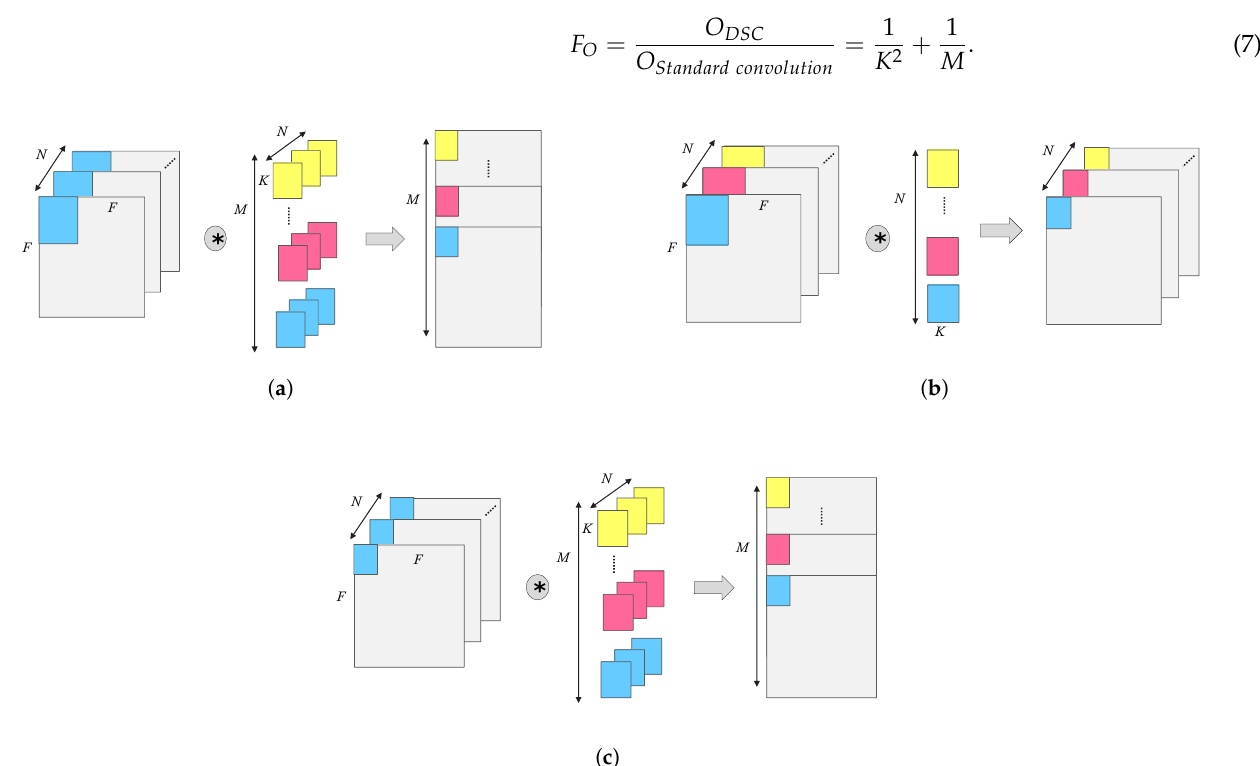
Figure 3. Standard convolution and depthwise separable convolution. ( a ) Standard convolution; ( b ) depthwise convolution; ( c ) pointwise